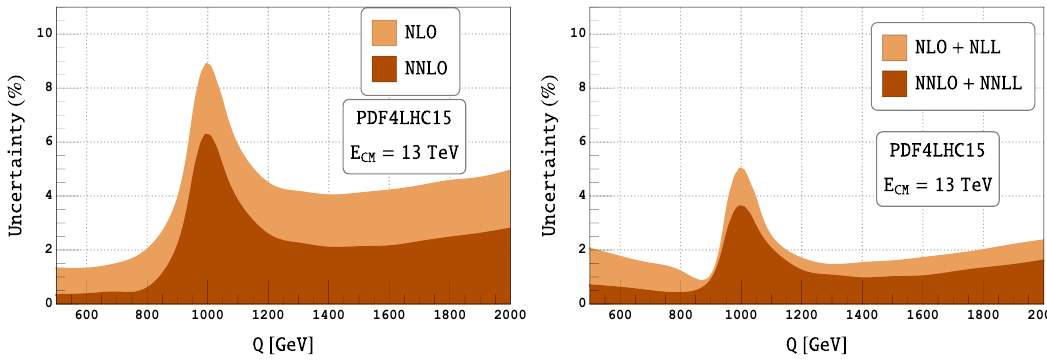
Figure 9 . The 7-point scale variation in the signal in the range ( µ r , µ f ) ∈ (1 / 2 , 2) is shown up to NNLO and NNLO+NNLL for the dilepton invariant mass distribution.